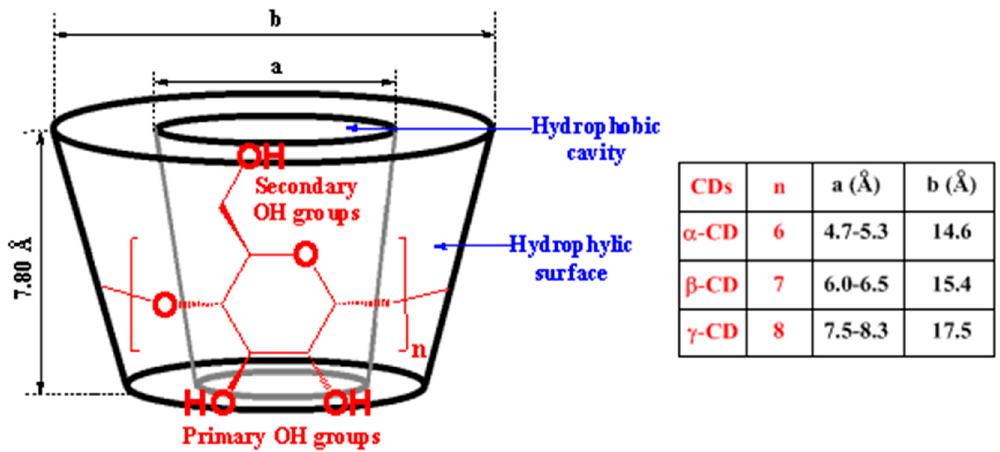
Figure 3. Chemical structure of natural α , β , and γ -cyclodextrins.